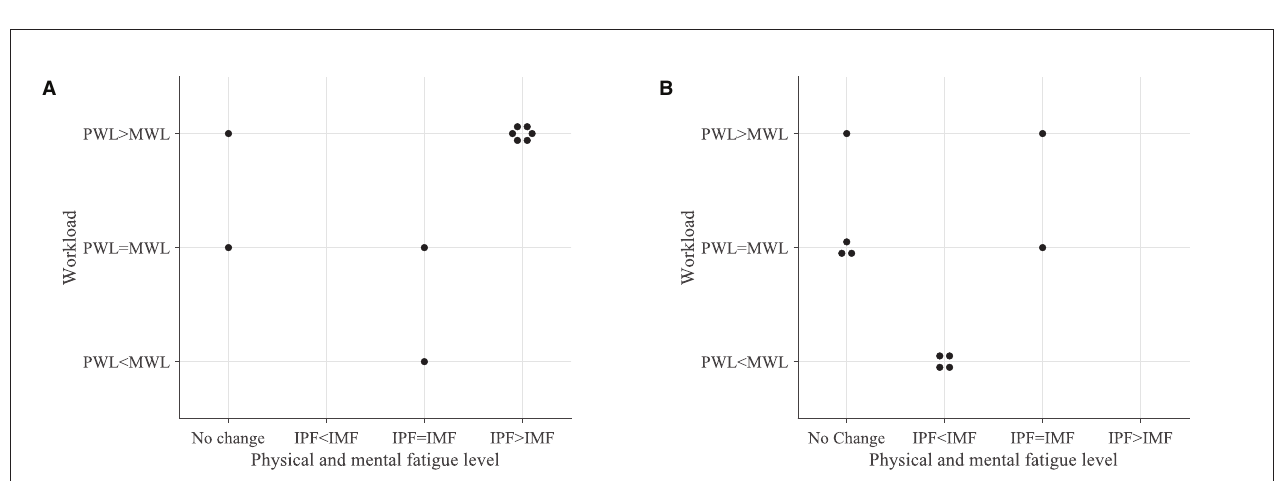
FIGURE 11 | Association between the variations in fatigue levels and the rated workload following the (A) robot-mediated gross motor interaction with HapticMASTER and (B) robot-mediated fine motor interaction with SCRIPT passive orthosis. The “IPF” and “IMF” refers to the increase in physical and mental fatigue scores following the robot-mediated interactions, respectively. No change refers to no increase or a decrease in both fatigue levels. The “PWL” and “MWL” refers to the rated physical and mental workload,